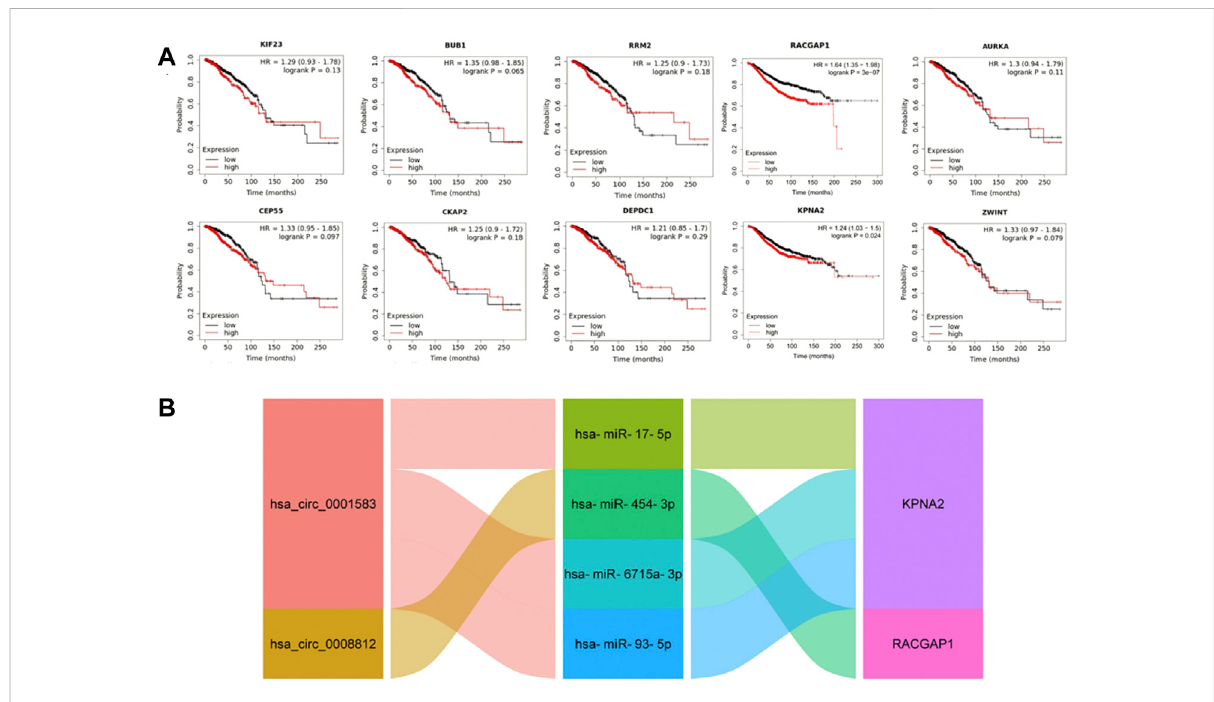
FIGURE 5 The construction of prognosis-related ceRNA network. (A) Kaplan-Meier survival analysis of hub genes. (B) The prognostic sub-network of